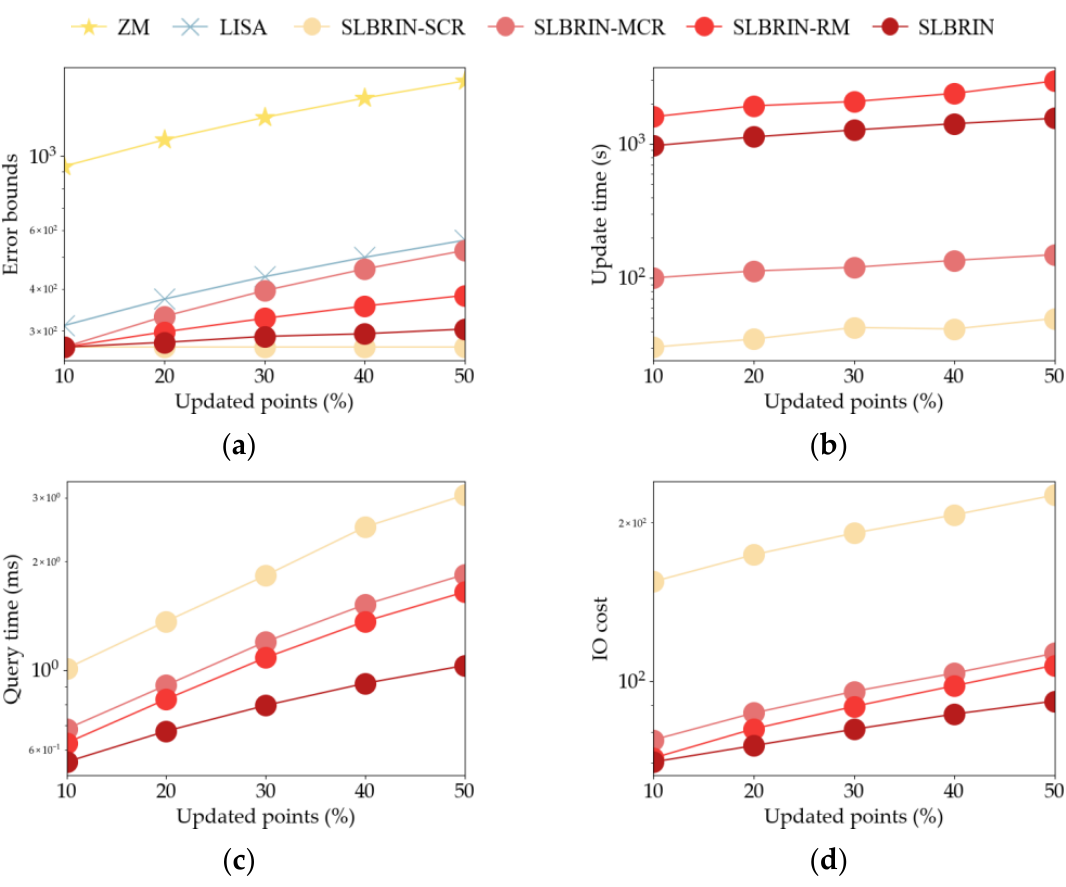
Figure 10. Update performance of SLBRIN variants vs. updated points. ( a ) Error bounds. ( b ) Update time. ( c , d ) Range query performance.